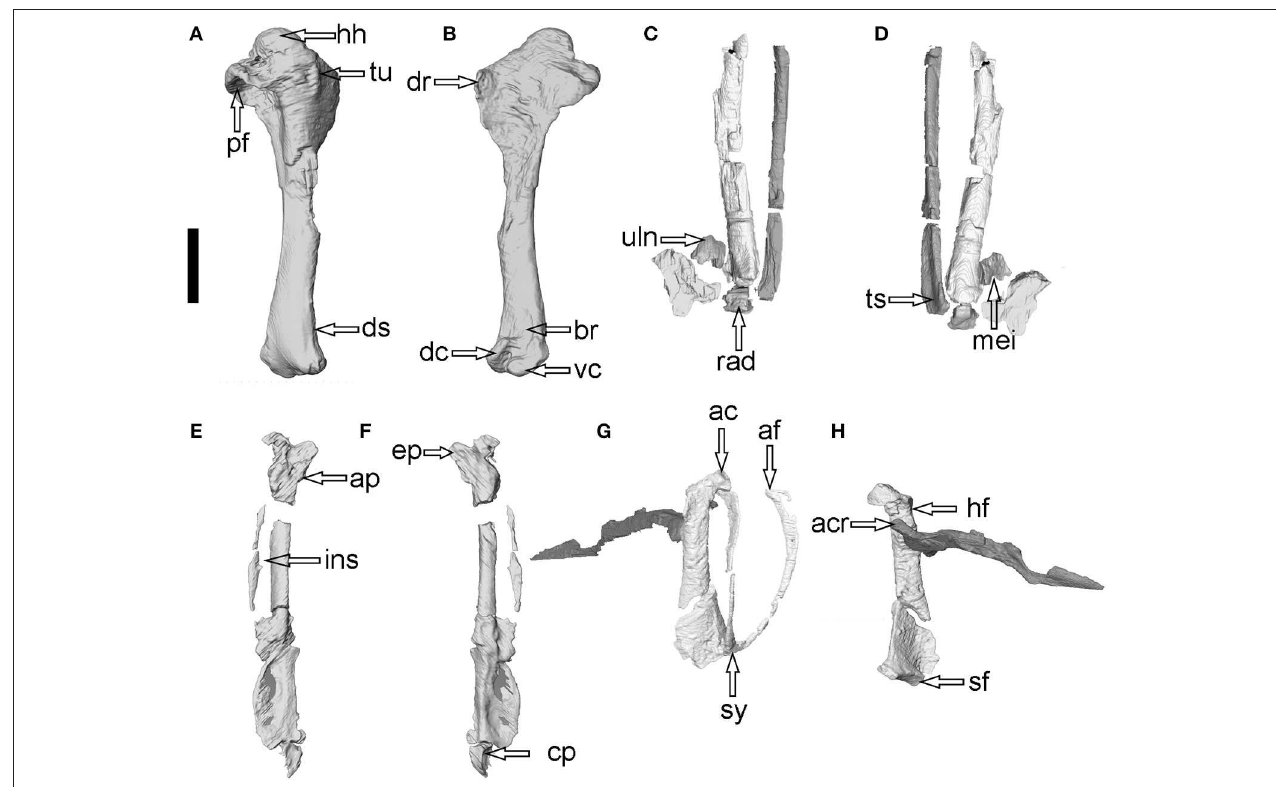
FIGURE 3 | Extracted individual bone elements to show detailed features of the forelimb and shoulder girdle of Linxiavis inaquosus (IVPP V24116). (A,B) cranial and caudal view of the right humerus; (C,D) dorsal and ventral view of the proximal forelimb (left side) with a focus of the ulna radius and carpal bones; (E,F) dorsal and ventral view of the distal forelimb with a focus of the carpometacarpus and phalanges (left side); (G,H) lateral and dorsomedial view of the shoulder girdle. Anatomical abbreviations: ac–acrocoracoid process of coracoid, acr–acromial process of scapula, af–acromial process of furcula, ap–alular process, br–brachial fossa, cp–caudal process, dc–dorsal condyle, dr–deltopectoral crest, ds–dorsal supracondylar tubercle, ep–extensor process, hf–humeral articular facet of coracoid, hh–humeral head, ins–intermetacarpal space, mei–metacarpal incisura, pf–pneumotricipital fossa, rad–radiale, sf–sternal articular facet of coracoid, sy–symphysis of furcula, ts–tendinal sulcus, tu–tubercle, uln–ulnare, vc–ventral condyle. Scale bar equals